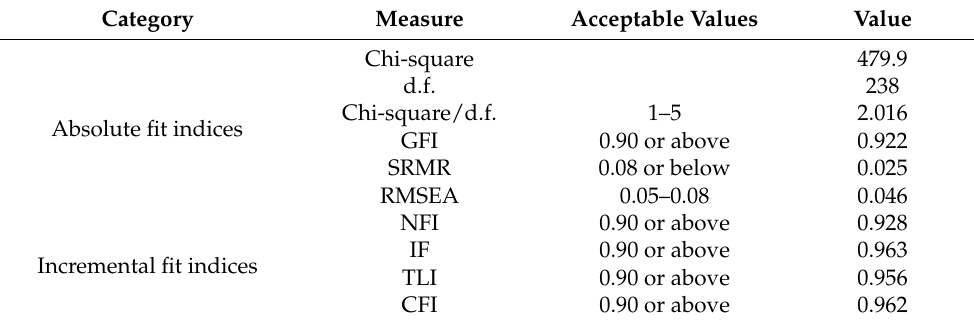
Table 5. Goodness-of-fit test.